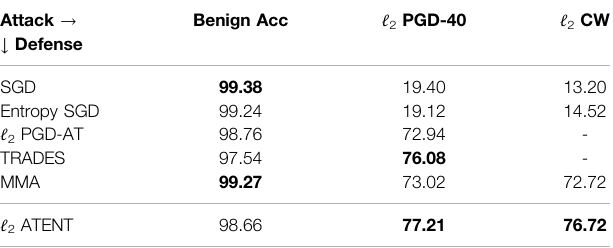
The highest two accuracy values in each column are highlighted in bold.